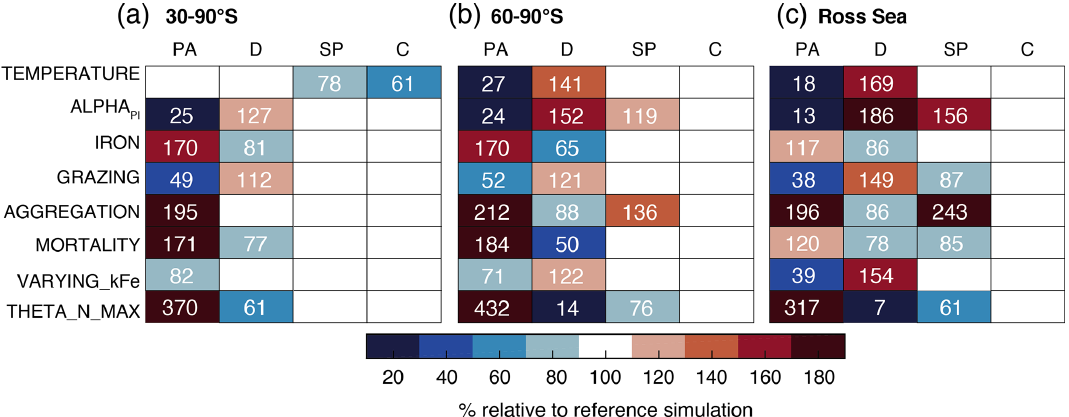
Figure A2. Annual mean surface chlorophyll concentrations of Phaeocystis (PA), diatoms (D), small phytoplankton (SP), and coccol- ithophores (C) in the competition sensitivity simulations (see Sect. 2.2 and runs 1–8 in Table 2) relative to the Baseline simulation. The model output is averaged over (a) 30–90 ◦ S, (b) 60–90 ◦ S, and (c) the Ross Sea. Numbers are only printed if the relative change exceeds ±